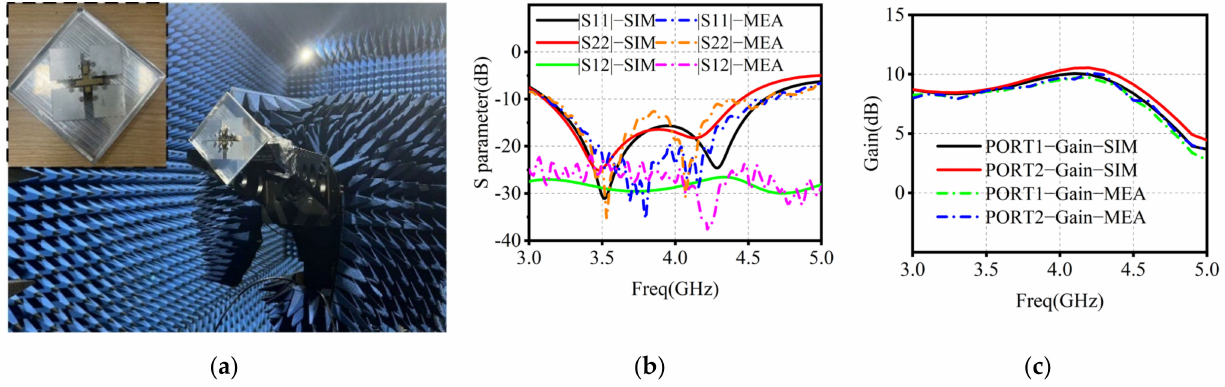
Figure 6. ( a ) Photograph of the prototype in measuring; ( b ) simulated and measured S parameters; ( c ) simulated and measured gain of port1 and port2.